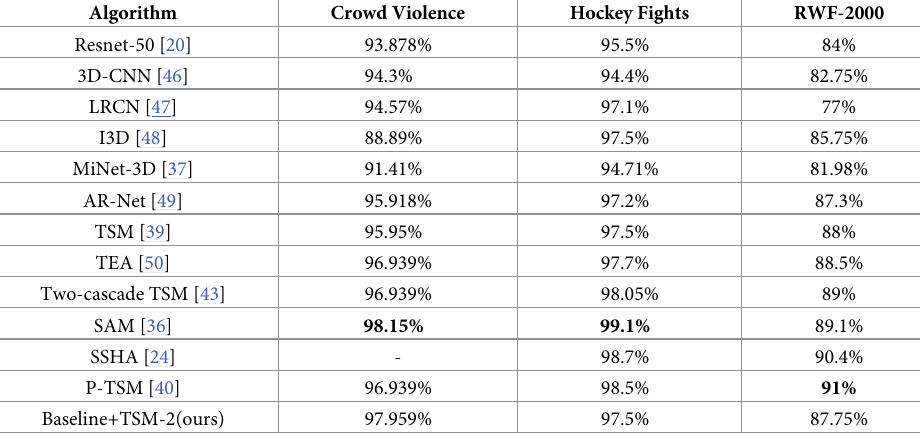
Table 4. Comparison of optimal accuracy of different